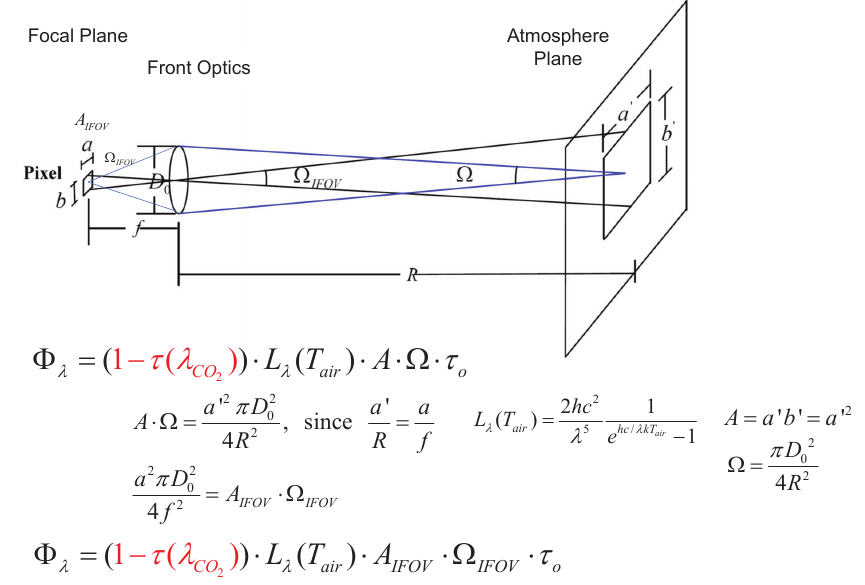
Figure 13. Geometrical model of received thermal flux in a pixel.